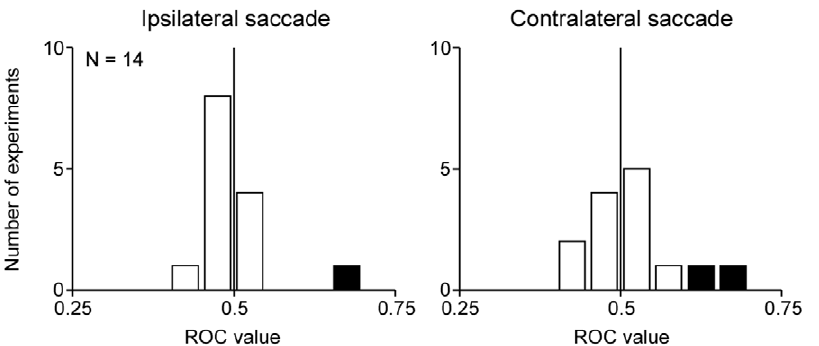
Figure 4. Effect of MD stimulation on saccade latency. Distributions of the ROC values comparing saccade latency between the stimulation and no-stimulation conditions are shown for ipsilateral saccades (left) and contralateral saccades (right) (N=14). Conventions are the same as Fig. 2 B .